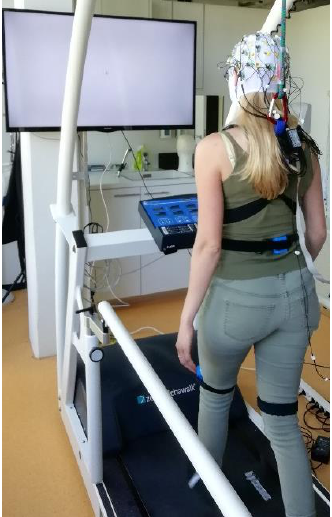
Figure 2. The participant is wearing the 32-channel EEG cap with active electrodes while walking